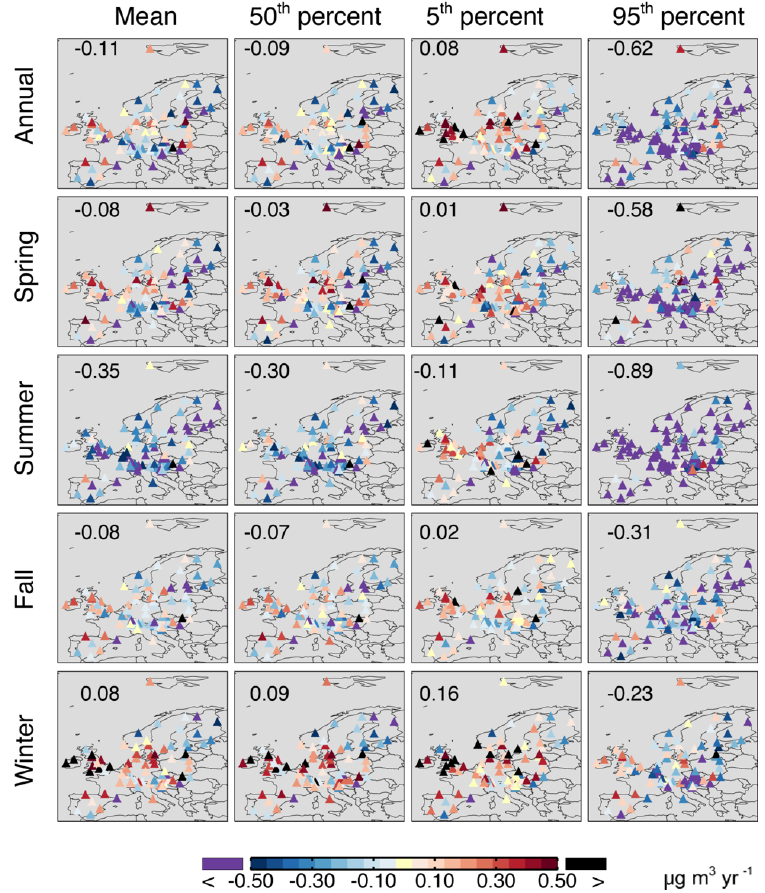
Figure 5. Spatial distribution of measured daytime ozone trends in µgm − 3 yr − 1 across the selected 93 sites for average, 5th, 50th, and 95th percentile ozone in annual mean and four seasons. Also shown in each panel are the average trends over all sites.